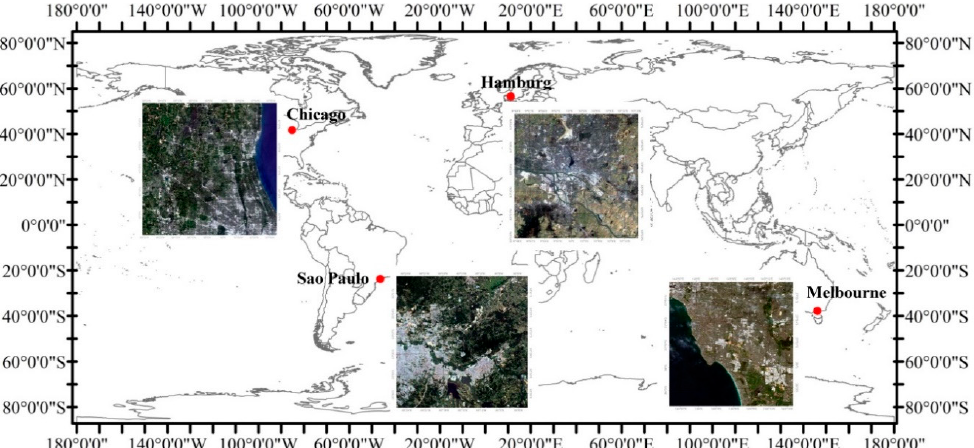
Figure 1. Geographic locations of the four selected cities, the images are true color composite of Landsat 8 data (R: band 4, G: band 3, B: band 2).